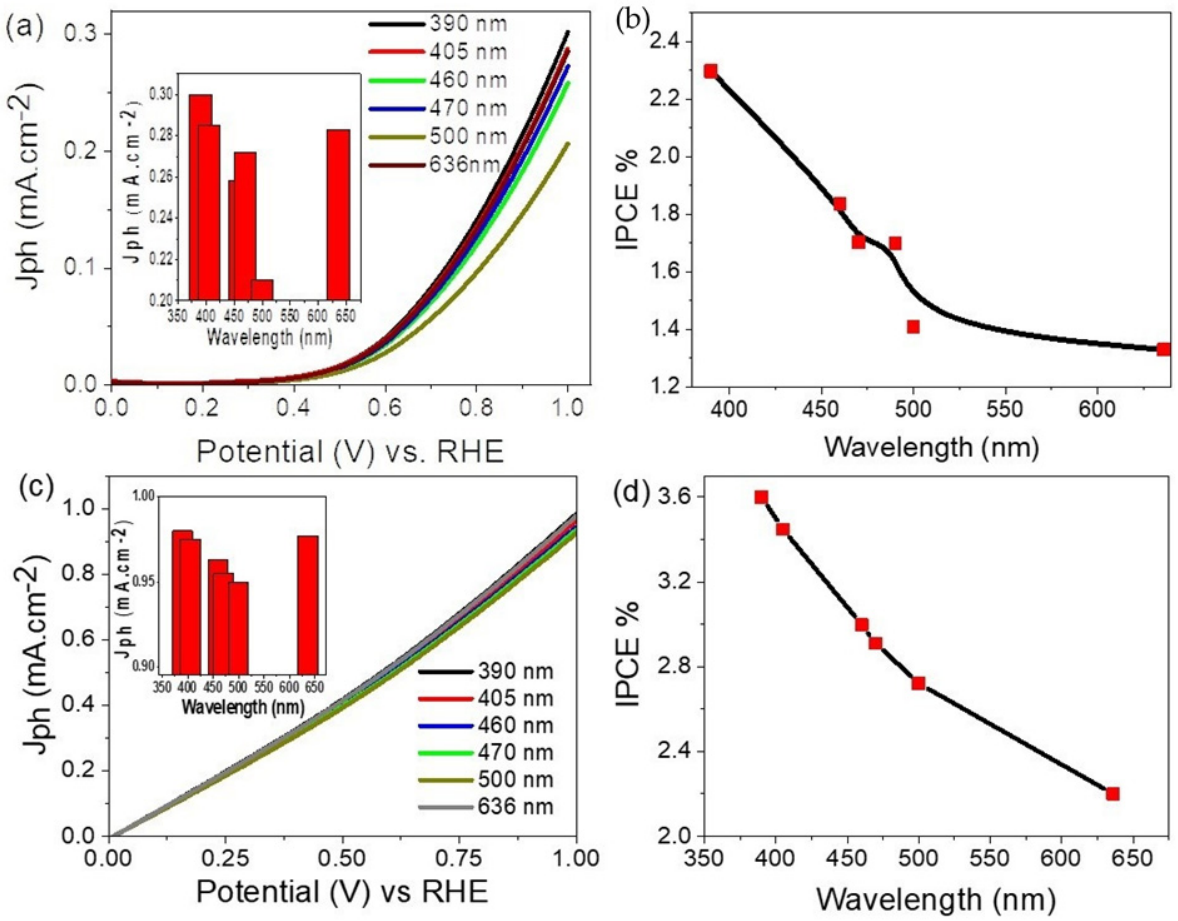
Figure 8. ( a ) The response of the PMT/Au-2 min electrode under different monochromatic light from 390 to 636 nm using electrolytes ( a ) Na 2 S 2 O 3 and ( c ) sewage water. The IPCE through using ( b ) Na 2 S 2 O 3 and ( d ) sewage water electrolyte.